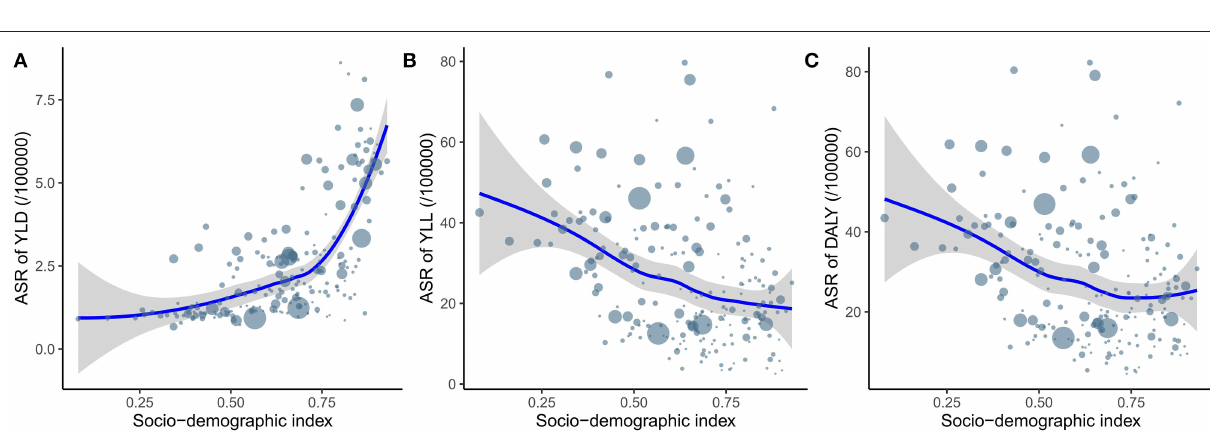
FIGURE 4 | The relationship between ASR of YLD (A) , YLL (B) and DALY (C) and SDI. ASR, age-standardized rate; YLD, year lived with disability; YLL, year of life lost; DALY, disability-adjusted life year; SDI, socio-demographic